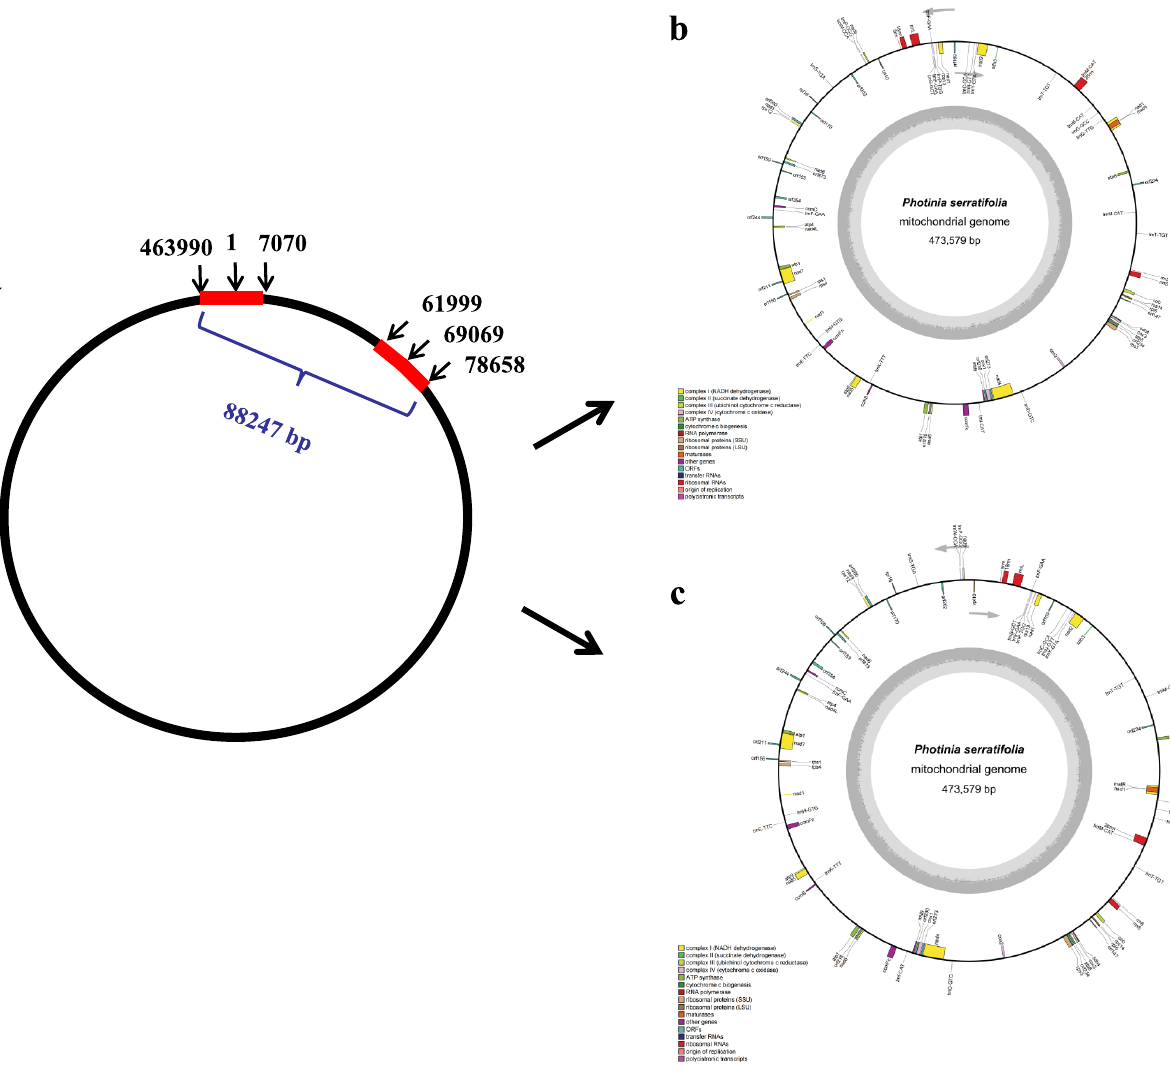
Figure 4. The distribution of the pair of long repeats and the possible configurations generated from inversions of these long repeats. a: The distribution of the pair of long repeats (16660 bp) (red bars) in the P. serratifolia mitogenome. b and c: Two possible configurations generated from inversions of these long repeats. b is the master conformations, which is same as Fig. 1 shown. c is an alternative configuration of mitogenomes of P.